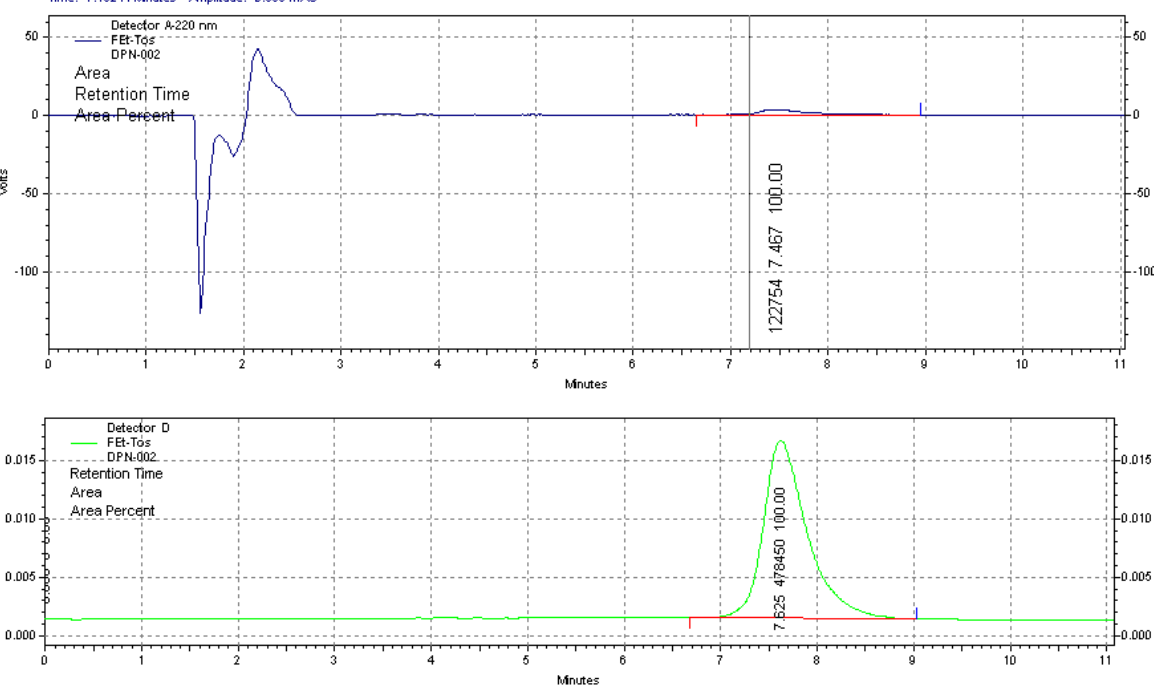
Figure 2. HPLC chromatogram from quality control of formulated [ 18 F]FDPN. Upper